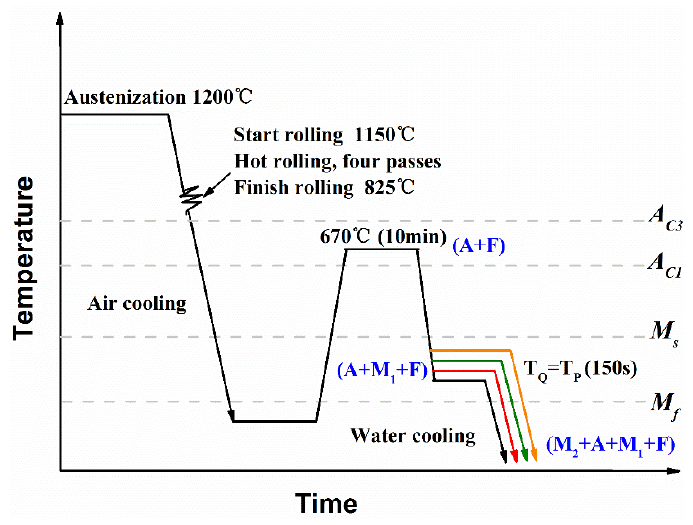
Figure 1. Heat treatment process flow.